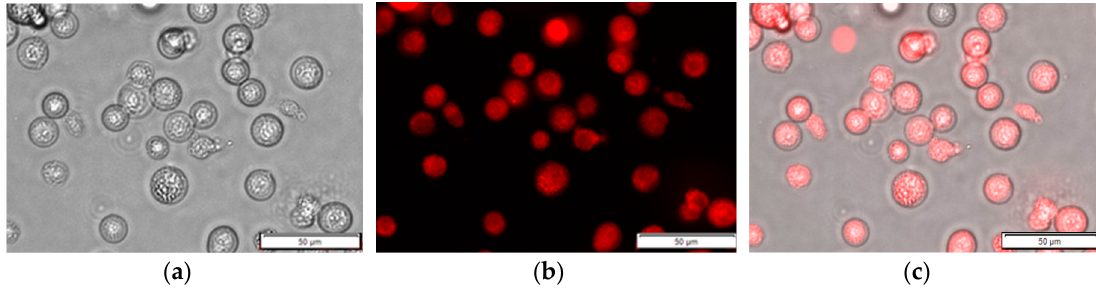
Figure 1. Representative R6G treated images of HeLa cells under a microscope with 200 magnification ( a ) bright field image; ( b ) fluorescence image; ( c ) merged image of fluorescently labeled HeLa cells.